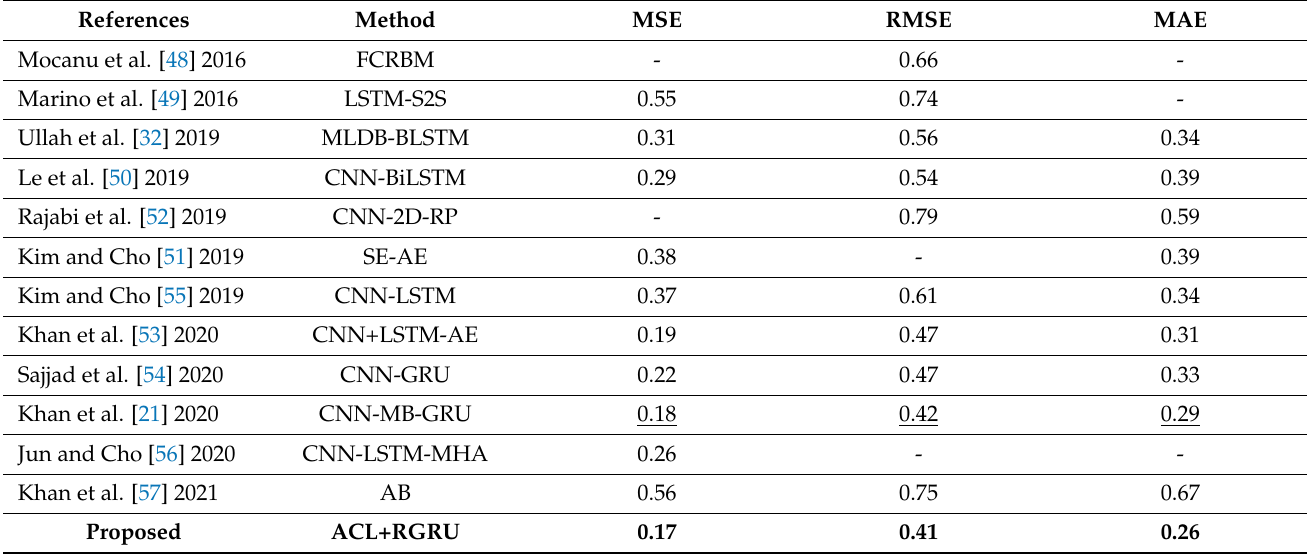
Table 6. Comparative analysis of the proposed method with state-of-the-art for hourly data resolution using IHEPC. Bold and underlined results demonstrate the best and runner-up